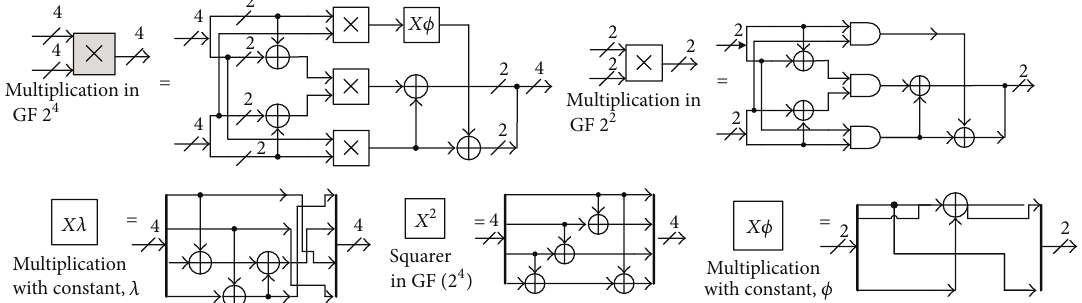
Figure 7: Individual blocks within the composite field S-box.